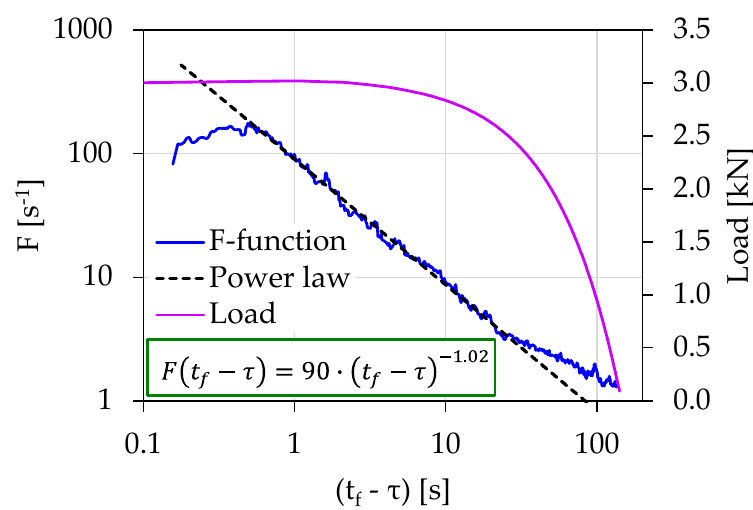
Figure 5. The temporal evolution of the F -function in juxtaposition to the load applied for the experiment Exp-LR1 in terms of the “time-to-failure” parameter.